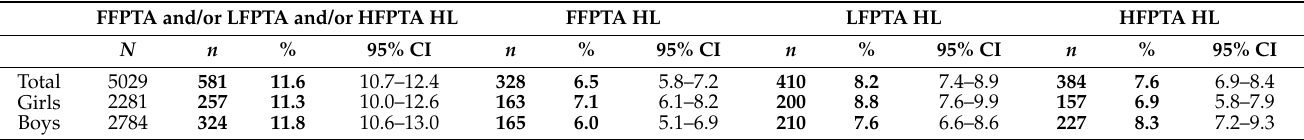
FFPTA, four-frequency pure-tone average; HFPTA, high-frequency pure-tone average; LFPTA, low-frequency pure-tone average; HL, hear- ing loss; N, study sample size; n, number of participants with positive result; CI, confidence